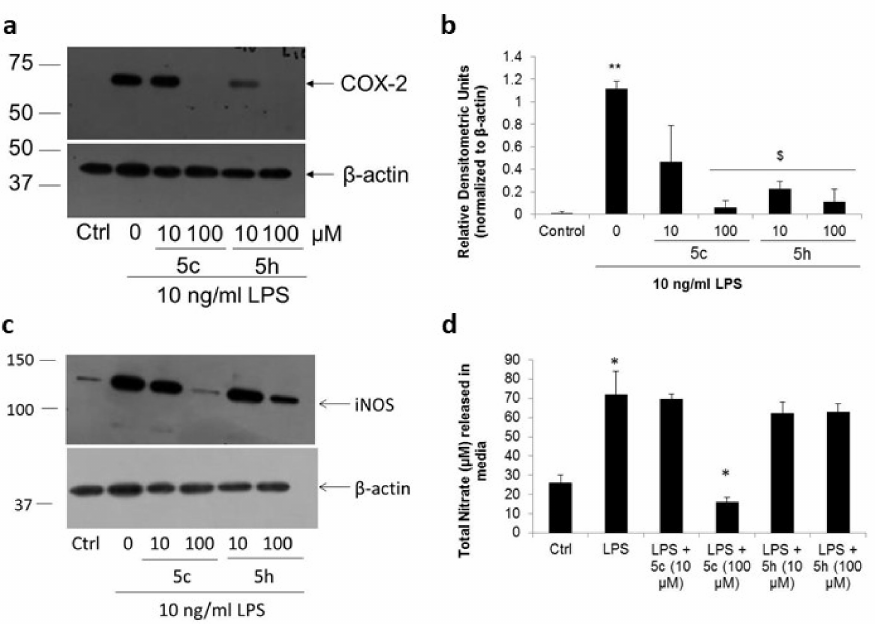
Figure 5. Substituted imidazo[1,2- b ]pyridazine compounds inhibit pro-inflammatory enzymes. ( a , b ) Primary rat microglial cells were stimulated with 10 ng/mL LPS in the presence or absence of compounds 5c or 5h for 24 h. Representative Western blot of COX-2 ( a ) and relative densitometric analysis shows both compounds 5c or 5h significantly inhibited LPS-induced COX-2 in microglial cells ( b ). ** p < 0.01 with respect to control cells, $ p < 0.05 with respect to LPS-treated cells. Error bars represent SEM, n = 3. ( c ) Representative Western blot for inducible nitric oxide synthase (iNOS). ( d ) Media supernatants were collected 24 h post-stimulation for the measurement of nitric oxide released in the culture media. * p < 0.05 with respect to control or LPS-treated